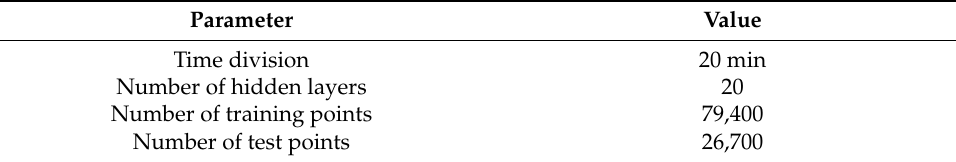
Table 3. Network static configuration parameters (when evaluating the impact of input delay length).